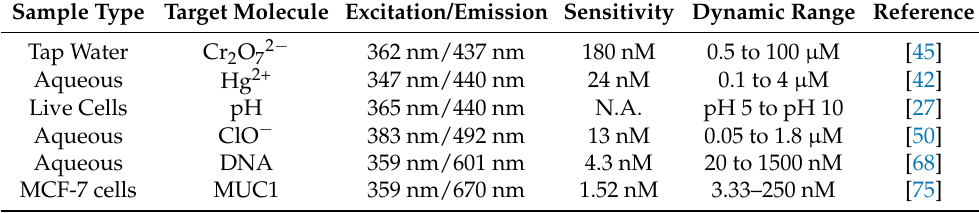
Table 2. Summary on the Performaces of SiQDs-based